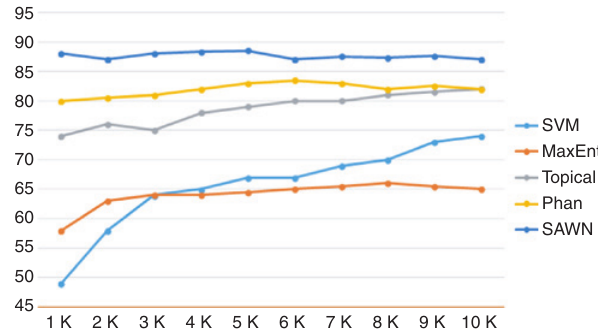
Figure 8: Results of the CBER Approach.